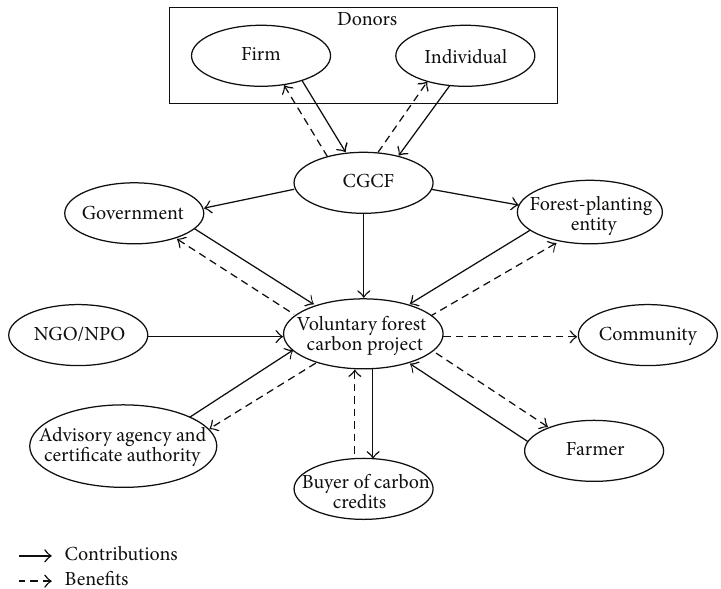
Figure 1: Stakeholder model of CGCF voluntary forest carbon offset projects in